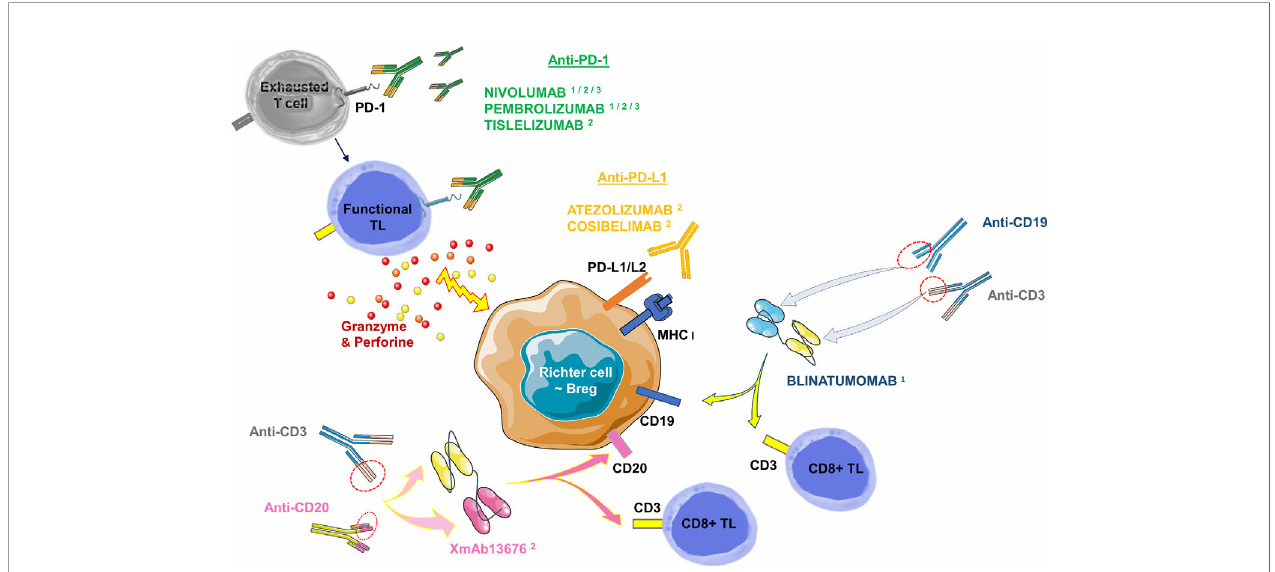
FIGURE 7 | Monoclonal antibodies targeting the PD-1/PD-L1 axis (checkpoint inhibitors) and bispeci fi c antibodies commercially available or in published/ongoing clinical trials in RS. Monoclonal antibodies targeting the PD-1/PD-L1 axis can be divided into two groups: i) against PD-1 receptor and ii) against its ligands PD-L1 or PD-L2. Anti-PD-1 antibodies are mainly represented by Nivolumab: a full human IgG4, and Pembrolizumab: a humanized IgG4. Tislelizumab (BGB-A317) is a new humanized IgG4 anti-PD-1 antibody. Anti-PD-L1 antibodies are mainly represented by Atezolizumab, a humanized antibody. Cosibelimab (TG-1501) is a novel, fully humanized anti-PD-L1 antibody. Bispeci fi c antibodies are designed to direct cytotoxic TLs expressing CD3 towards B-cells expressing CD19 (Blinatumomab) or CD20 (XmAb13676). Breg, Regulatory B Lymphocyte; MHC, Major Histocompatibility Complex; PD-1, Programmed Death 1; PD-L1, Programmed Death Ligand 1; PD-L2, Programmed Death Ligand 2; TL, T Lymphocyte. 1 : commercially approved in other hemopathies (relapsed Hodgkin Lymphoma for Nivolumab and Pembrolizumab, relapsed/refractory Acute B Lymphoid Leukemia for Blinatumomab). 2 : clinical trials published in RS. 3 : clinical trials underway in